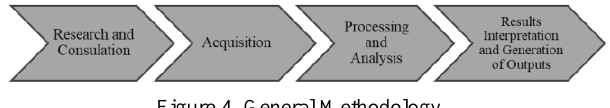
Figure 4. General